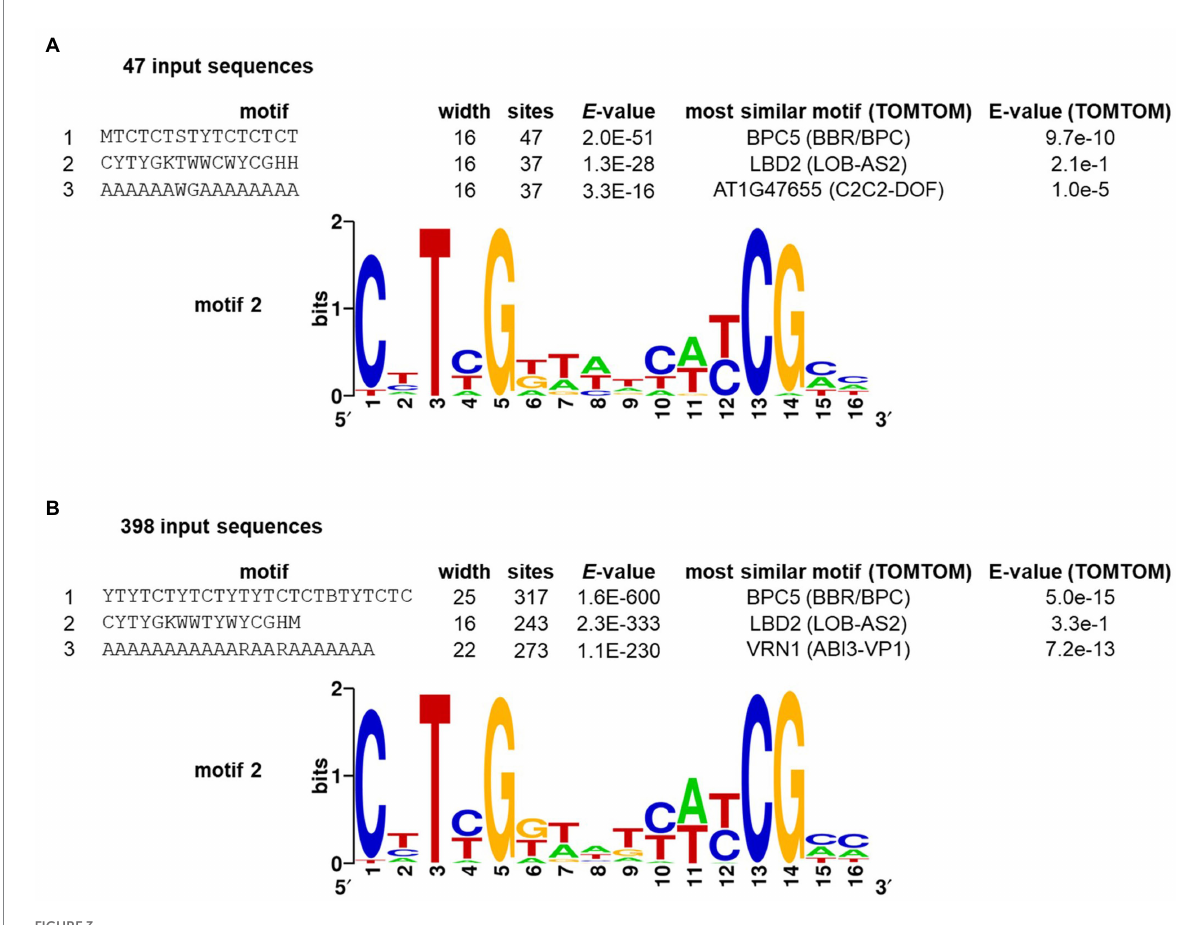
FIGURE 3 De novo discovery of cis-elements upstream of WRI1 co-regulated genes by the MEME algorithm, requesting 15 motifs of length 5 to 25 nc. WRI1 targets were identified by a co-expression network (Supplementary Figure 3). Listed motifs from the MEME output were searched against A. thaliana DAP-seq motifs (O'Malley et al., 2016) using the motif comparison tool TOMTOM of the MEME suite (Bailey et al., 2009). (A) motifs detected in upstream regions of 47 A. thaliana genes found to be co-expressed to WRI1 (see text). Motifs with E -value <1E-10 are listed. (B) motifs detected in a set of 398 upstream regions. The 47 sequences from panel A were extended by 351 orthologous upstream regions from other species. The three top-ranking motifs from the MEME output are